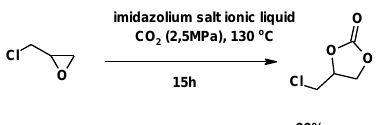
Figure 22. Synthesis of cyclic carbonates, using vinyl-functionalized di-imidazolium salts polymers as the catalyst.